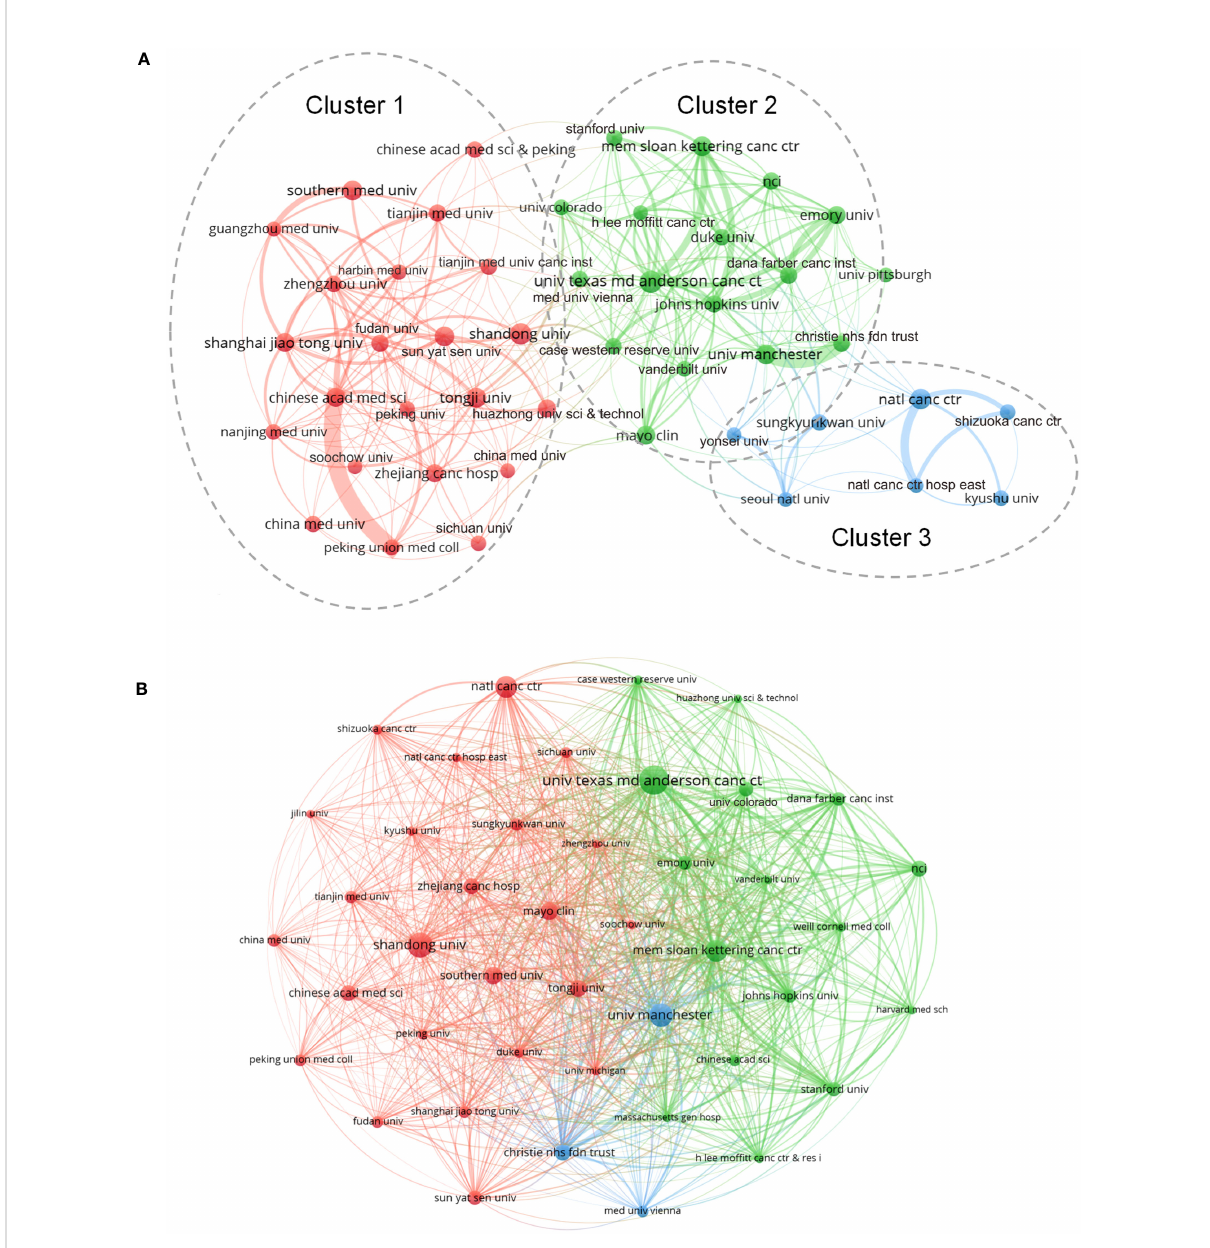
FIGURE 4 (A) Co-authorship relationships between organizations. Cluster 1; Chinese organizations (Red node cluster); Cluster 2; European and American organizations (Green node cluster); Cluster 3; Japanese and Korean organizations (Blue node cluster). (B) Citation relationships between organizations. Top3 TLS was: The Chinese Academy of Medical Sciences (TLS=68), The University of Texas MD Anderson Cancer Center (TLS=65), and Memorial Sloan Kettering Cancer Center